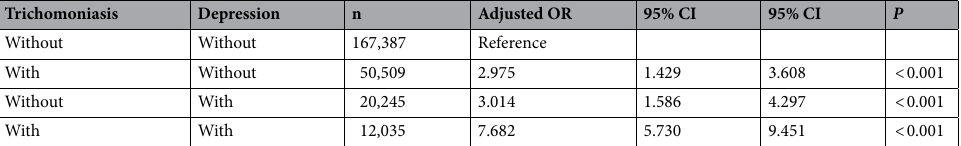
Table 5. Risk of BPH/prostate cancer or bladder cancer stratified by trichomoniasis and depression status using logistic regression. Adjusted OR adjusted odds ratio (adjusted for variables listed in Table 2), CI confidence interval.